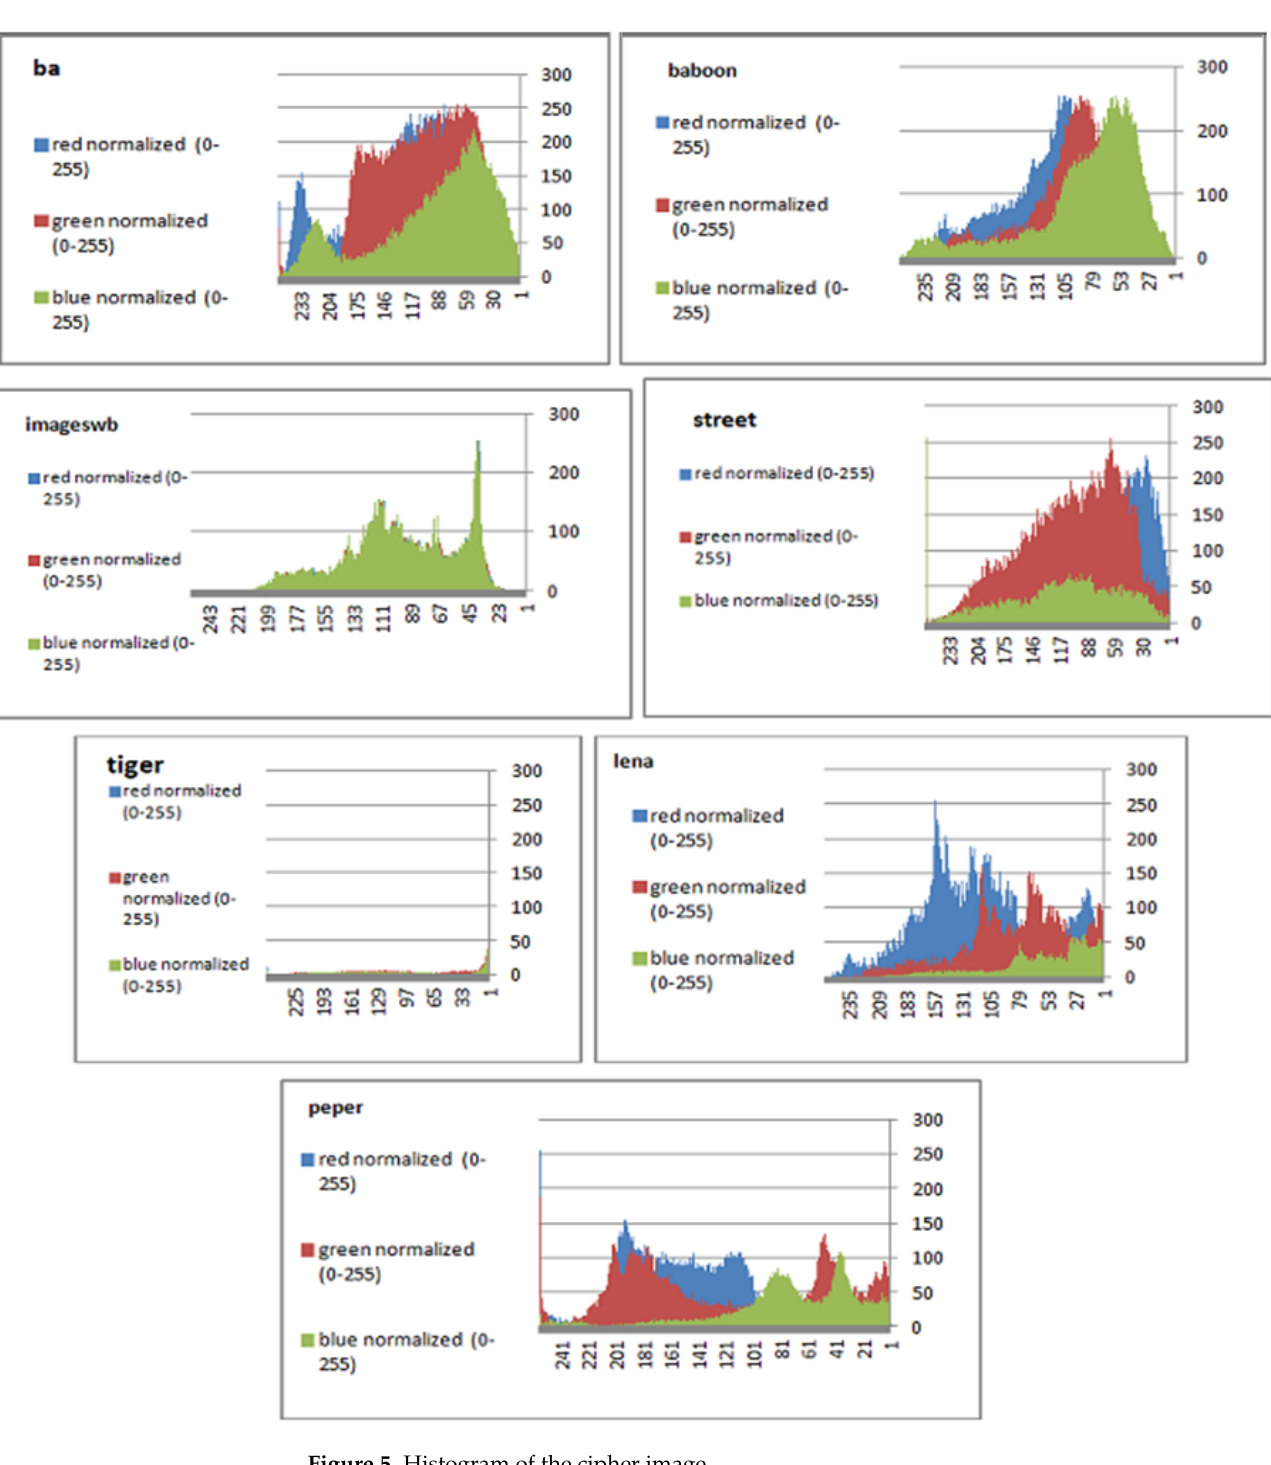
Figure 5. Histogram of the cipher